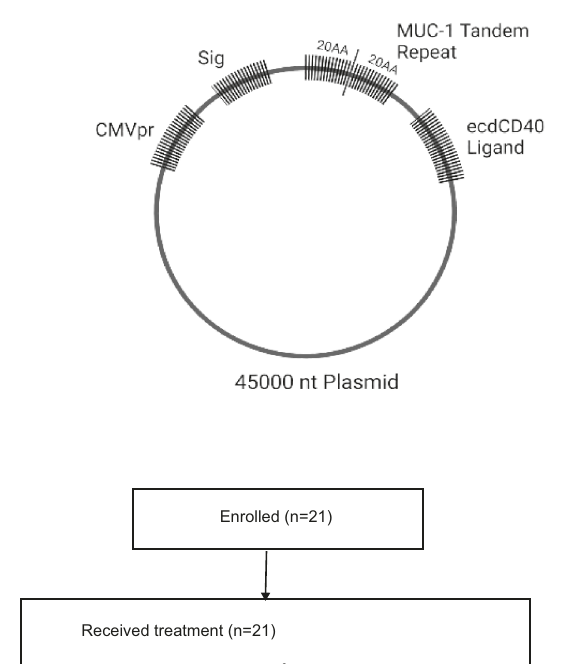
Fig. 1 | Vaccine vector and trial fl ow diagram. a Schema of vaccine expression vector. b Trial fl ow diagram and vaccination regimen. Dosage numbers indicate